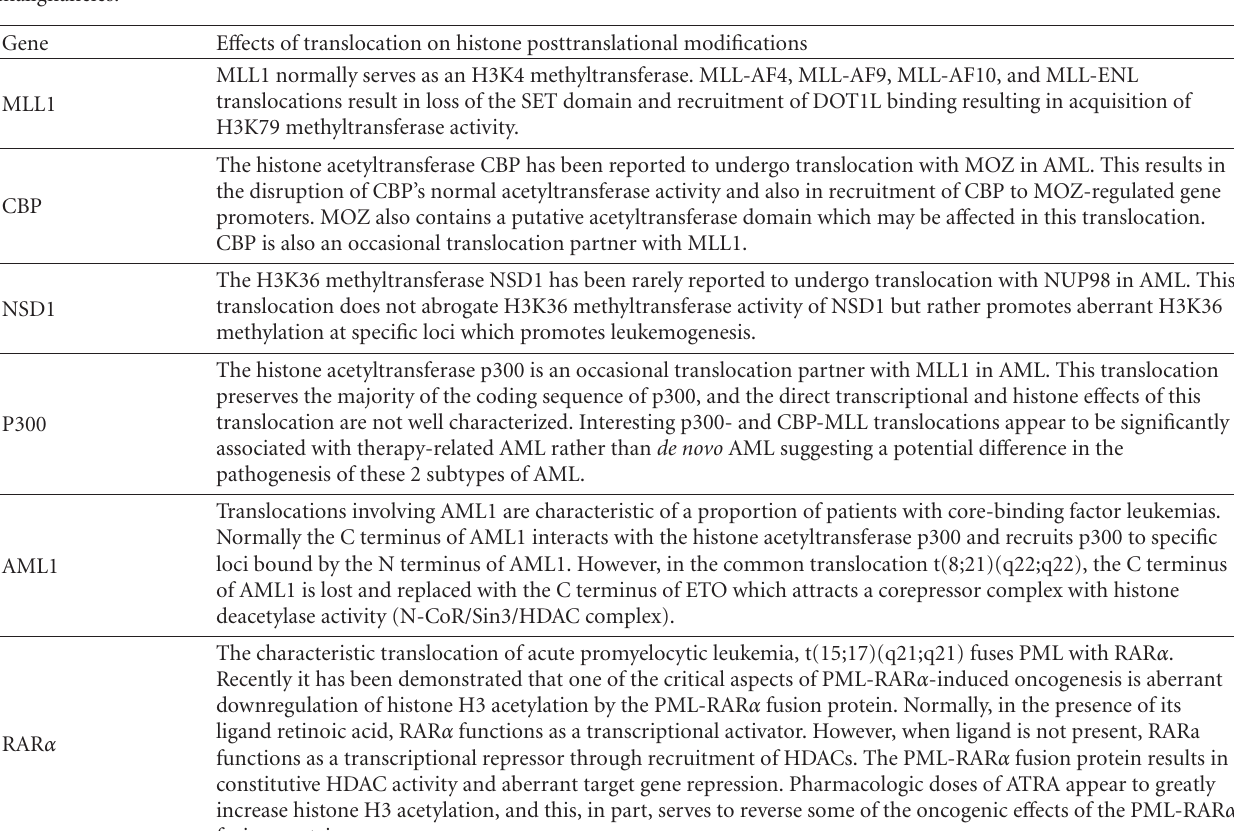
Table 1: Translocations directly a ff ecting histone modifying enzymes or recruitment of histone modifying enzymes in patients with myeloid